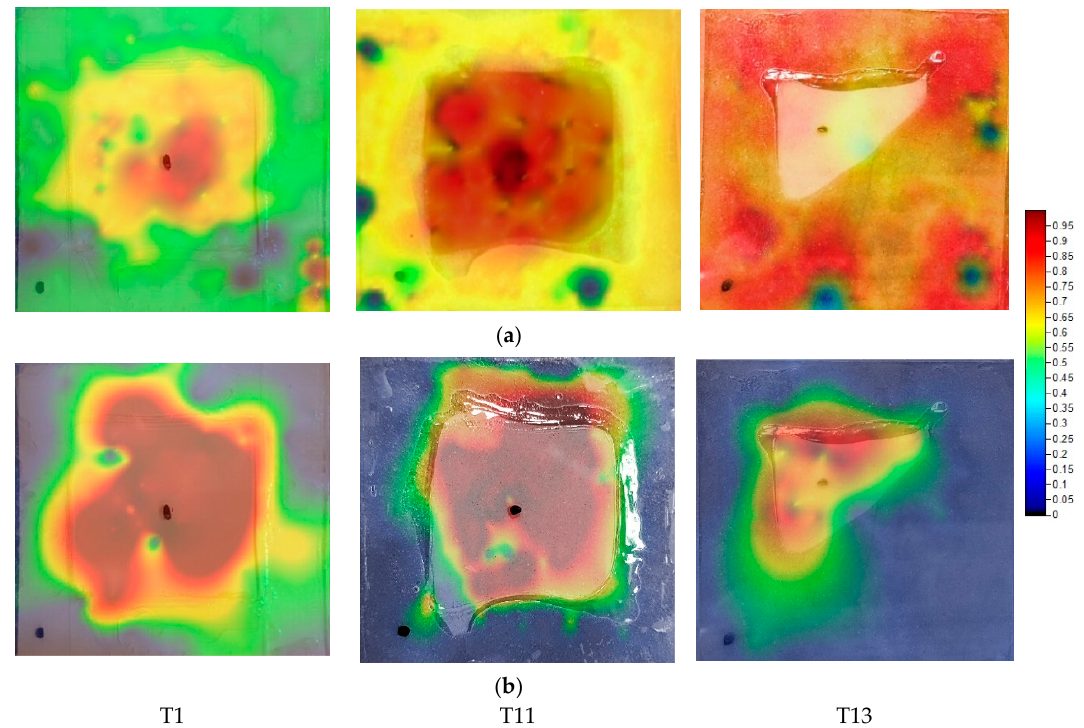
Figure 12. PICUS measurements on the tile models with artificial delamination T1, T11 and T13, using the two data processing methods: the audio data processing at the top ( a ), the impact-time processing at the bottom ( b ). The reference point is marked with a black point at the center of the